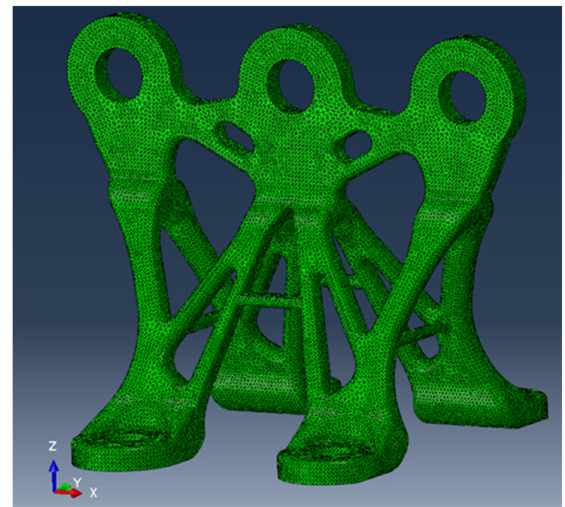
Figure 13. The mesh diagram of new bracket.